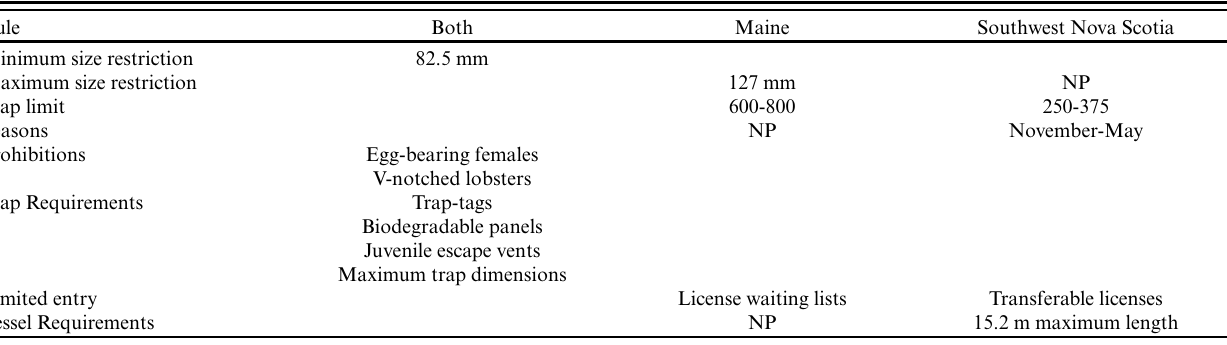
Table 2 . Comparison of rules governing the Maine and Port Lameron lobster commons. NP indicates that a rule is not present in that social-ecological